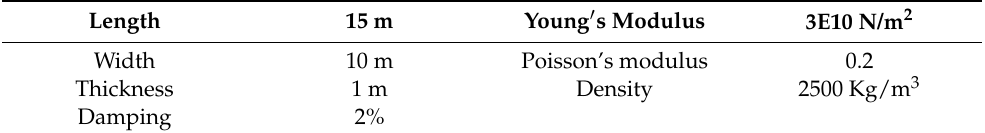
Table 6. Properties of the simulated short bridge.